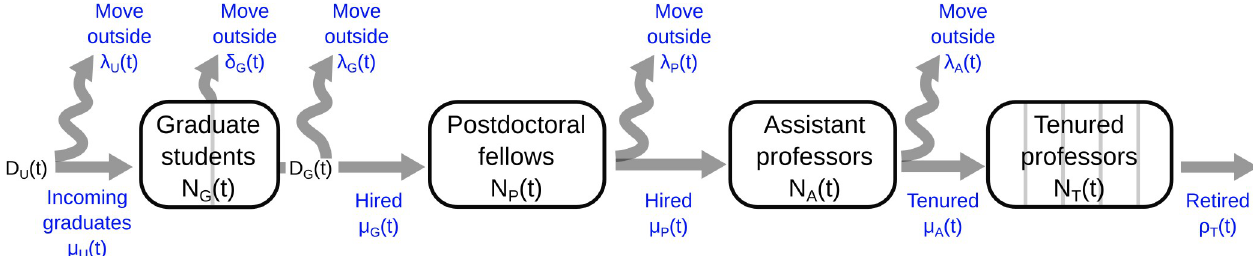
Fig 1. Model schematic. Academia is represented as a series of stages, where individuals either move to the next stage, or move outside of the system (academia) to other career paths. Black text indicates NSF data, blue text indicates estimated data. The stages for graduate students (G) and tenured professors (T) are split into sub-partitions (grey lines), representing pre- and post-exam stages for graduate students and equally spaced intervals for tenured professors.